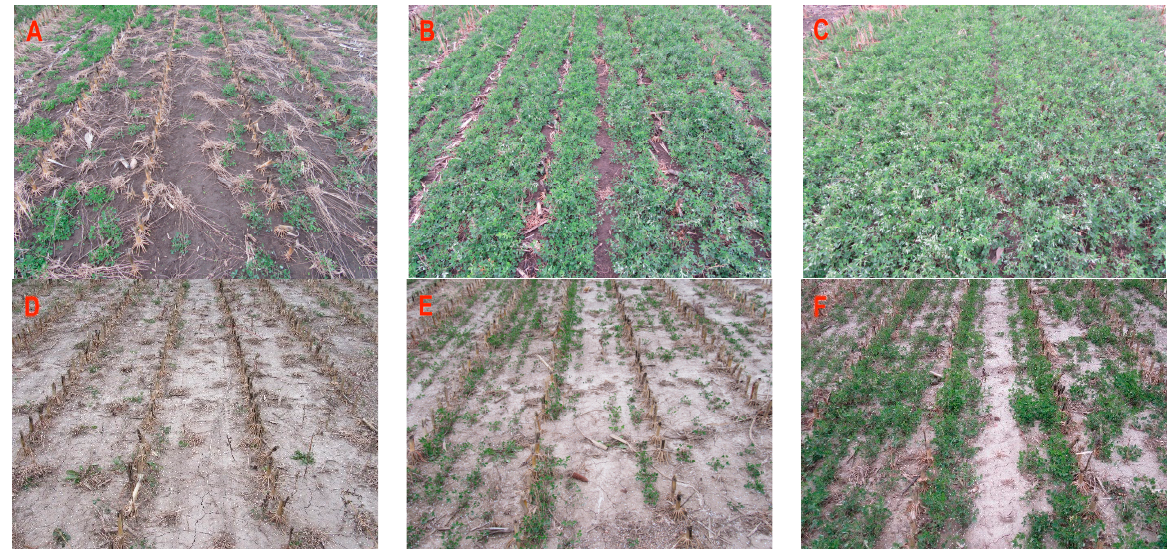
Figure 7. Photographs of interseeded alfalfa in late October 2017 (A, B, C) and late October 2018 (D, E, F) approximately seven weeks after corn silage harvest. Agrichemical treatments applied to alfalfa during establishment consisted of a nontreated control (A, D), prohexadione (B, E), and prohexadione, followed by fungicide and insecticide (C, F). Corn population was approximately 79,000 plants ha − 1 at harvest in 2017 and 72,900 plants ha − 1 at harvest in 2018.